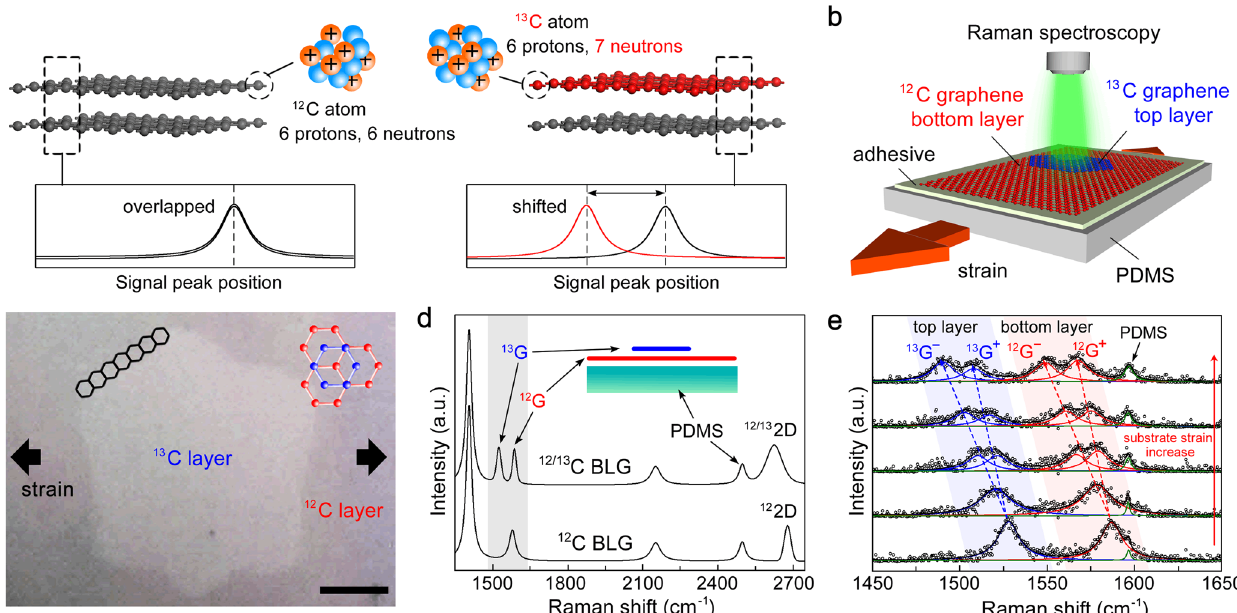
Fig. 1 Isotope-labeled Raman spectroscopy for AB-BLG and the evolution of the corresponding Raman peaks with increased strain. a Overlapped and differentiated Raman peaks from BLG composed of identical and isotope carbon atoms, respectively. b Schematic of the experimental setup for the shear property measurement of BLG by Raman spectroscopy. c OM image of a BLG island transferred on the formvar/PDMS substrate. d A typical Raman spectrum of AB-stacked 12 C/ 13 C BLG, compared with that of AB-stacked 12 C/ 12 C BLG. e Raman G peaks evolution of AB-stacked 12 C/ 13 C BLG with increased PDMS tensile strain. Scale bar in c : 5 μ